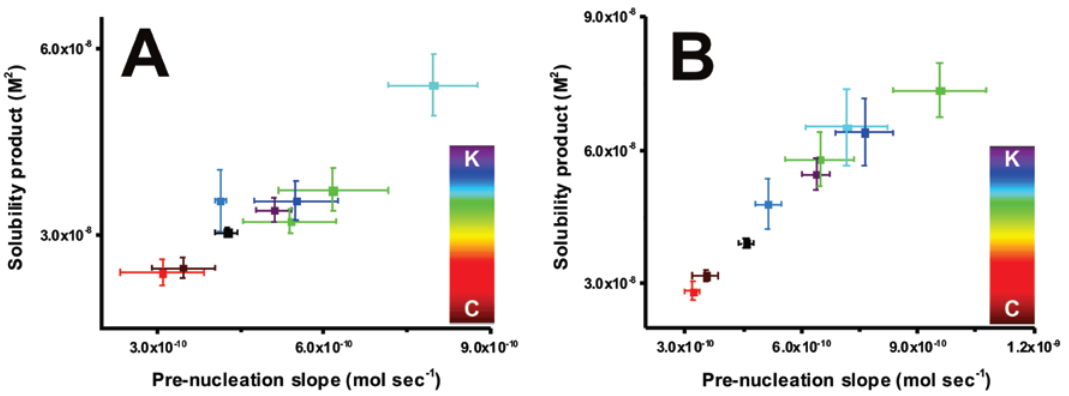
Figure 3. Scatter plots representing slopes of the pre-nucleation regime and corresponding solubility products of phases formed after nucleation at ( A ) pH 9.0 and ( B ) 9.75 in reference (black) and additive-containing (colored) titrations. The color scale represents the relative chao(C)-/kosmotropic(K) activities of guanidine, urea, mannitol, sorbitol, trehalose, glycine, betaine, and ectoine as determined by systematic studies on agar gelation [69]. Error bars depict ± one standard deviation.